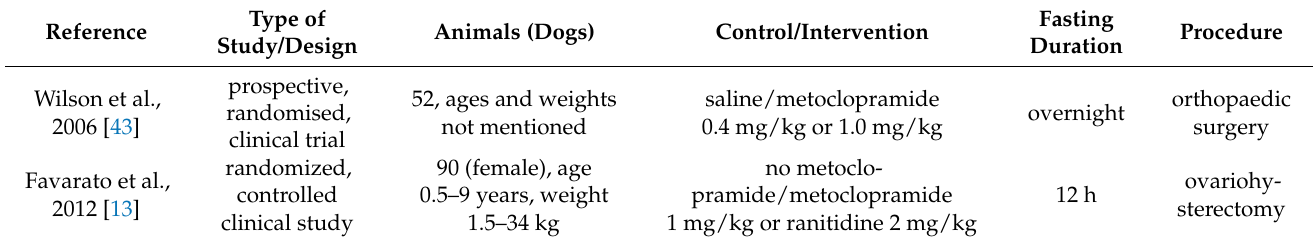
Table 6. Intervention: use of metoclopramide. Characteristics of the studies in dogs.